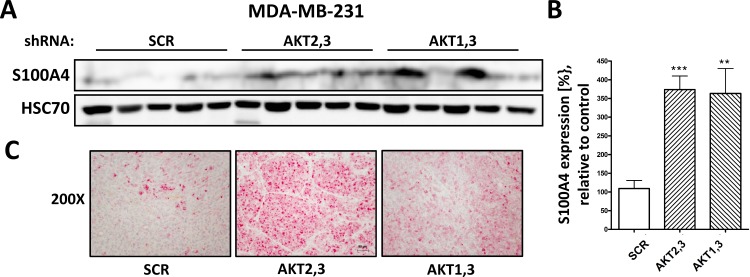
S100A4 is overexpressed in AKT3 lacking primary tumors.(A) Protein lysates were prepared from five primary tumors per group and expression of S100A4 was analyzed by Western blot analysis. (B) S100A4 expression was quantified from Western blot analysis of five primary tumor tissue samples. Data were normalized to corresponding HSC70 controls (Bars: SD. **, p < 0,01, ***, p < 0,001). (C) Immunohistochemical staining of S100A4 in xenograft tumor sections. One representative image is shown (magnification 200X).